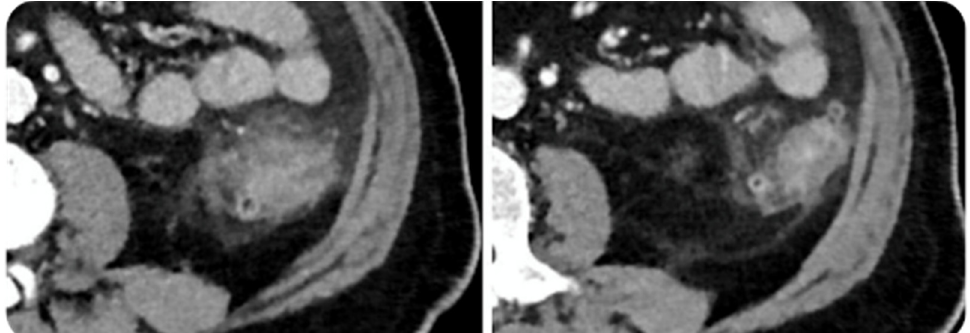
Figure 3. Complicated immune-related segmental colitis with diverticulosis pattern in a 76-year-old man with angiosarcoma and abdominal pain during Nivolumab treatment. CT images of two different slices show a segmental and circumferential descending colon wall thickening and pericolic fat stranding. © Department of Radiology, Candiolo Cancer Institute—FPO-IRCCs. Turin.